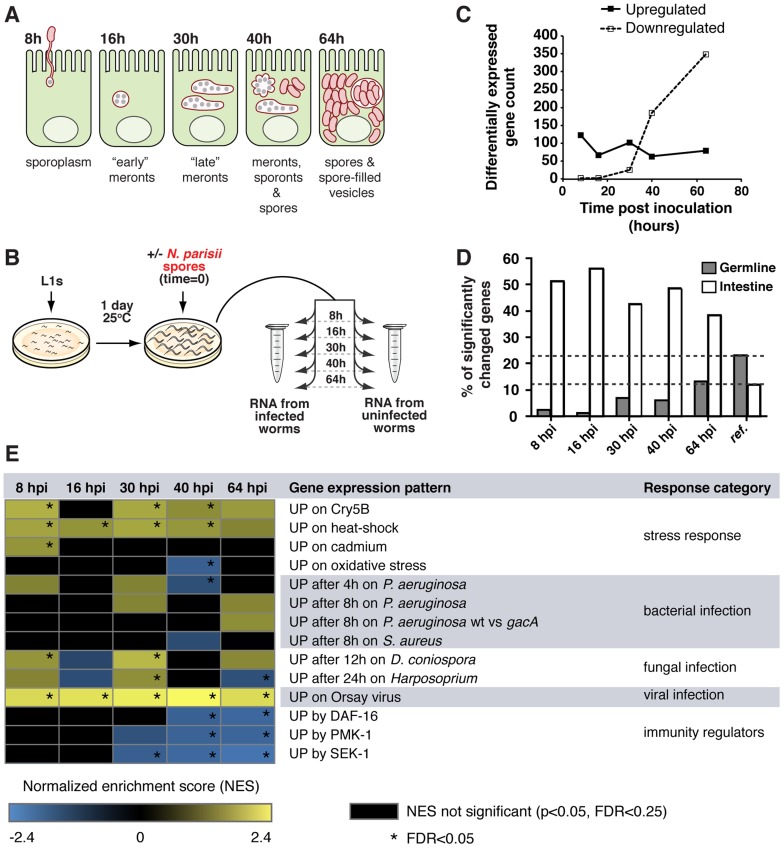

C. elegans gene expression during infection with N. parisii.A) Diagram of N. parisii infection stages in C. elegans intestinal cells. B) Synchronized populations of fer-15;fem-1 sterile animals were inoculated with N. parisii spores and collected for RNA extraction at timepoints corresponding to specific stages of infection. Uninfected controls were included for each timepoint. C) Number of significantly (FDR<0.05) up- or downregulated C. elegans genes during infection with N. parisii. D) Proportion of intestine- and germline-associated C. elegans genes with significantly altered expression at each timepoint. The “reference” bars indicate intestine or germline associated genes as a percentage of the C. elegans genome (20,404 genes). At each timepoint, 39% to 56% of all highly regulated genes were associated with the intestine, which represents a significant enrichment (chi-squared test, p<1.03E-26, all comparisons), while germline genes were significantly underrepresented (chi-squared test, p<1.51E-05, all comparisons) (Figure 1D, Table S2). E) Correlations between genes regulated by N. parisii infection and genes upregulated by other pathogens, stressors and immunity pathways. Gene sets were compared using the GSEA software (see Table S5 for detailed summary of results) and normalized enrichment scores (NESs) with a relaxed significance threshold (FDR<0.25, p<0.05) are reported in the figure. A positive NES (yellow) indicates a correlation with genes upregulated in response to N. parisii infection, while a negative NES (blue) indicates a correlation with genes downregulated in response to N. parisii infection (see Materials and Methods for analysis details). Black indicates no significant (FDR<0.25, p<0.05) correlation, and an NES with FDR<0.05 is indicated with an asterisk.